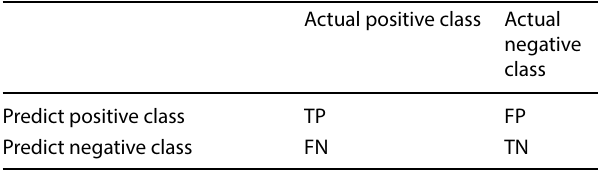
Table 1 Confusion matrix of classification problems